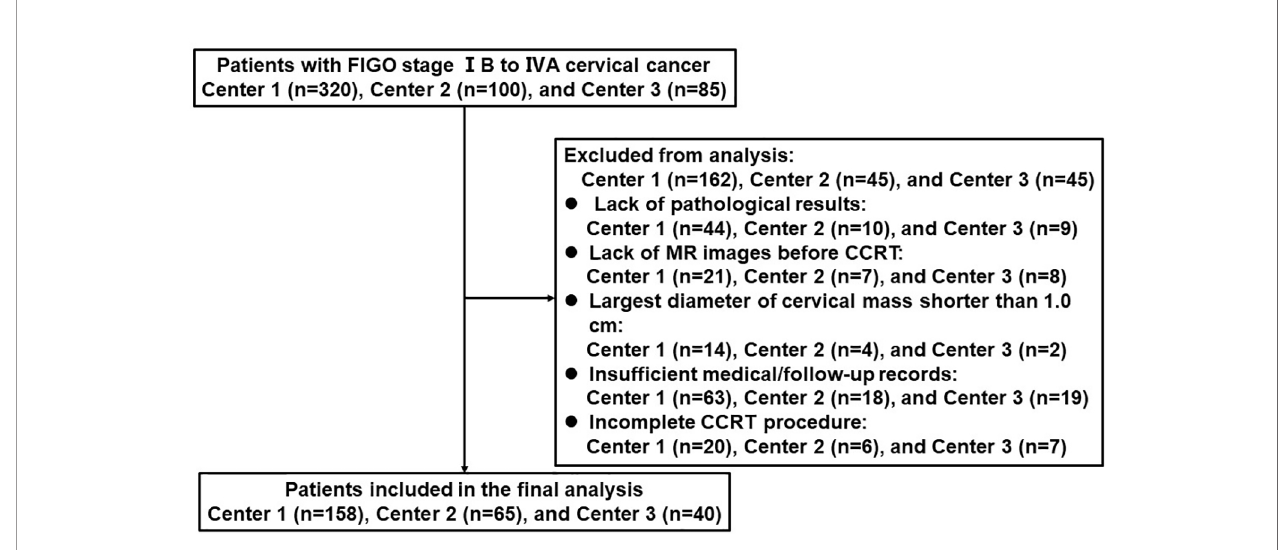
FIGURE 1 | Flow diagram of patient